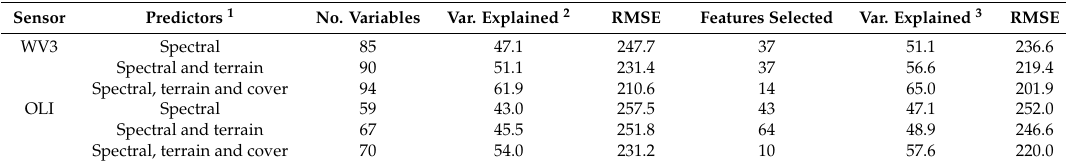
Table 4. Remote sensing based fine-fuel biomass (kg/ha) model results from Random Forest regression tree models with and without RFE predictor variable selection.